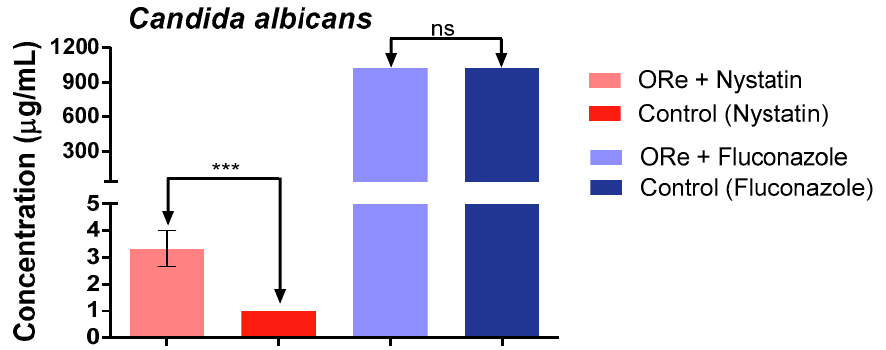
Figure 1. Minimum inhibitory concentration of nystatin and fluconazole in the presence and absence of R. echinus leaf essential oil for Candida albicans . ORe = R. echinus leaf essential oil. Statistical analysis: one-way ANOVA followed by Bonferroni post-hoc test. *** p < 0.001 indicates significant difference when R. echinus leaf essential oil was added to the medium. ns, not significant. Data show mean + SEM from three independent experiments performed in triplicate.